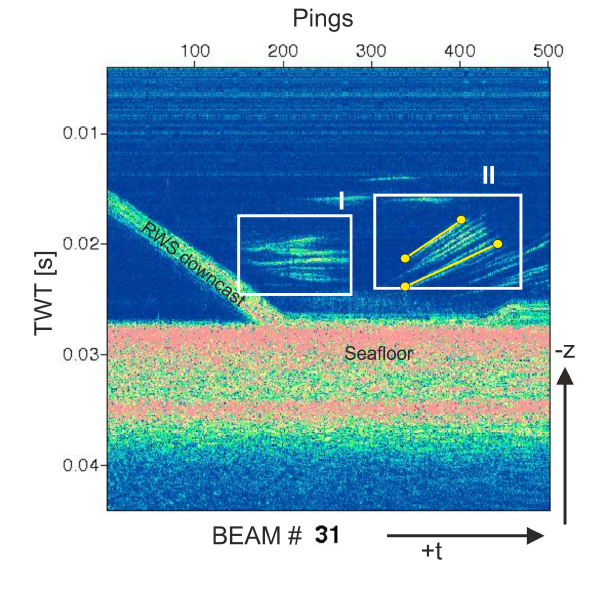
Fig. 3. “Beam slice” representation with the x axis corresponding to ping times (1 ping = 150ms) and the y-axis showing two-way- travel time for Beam 31. The downcast of the rosette-water-sampler (RWS) is seen in the left of the image. Horizontal straight lines are seen at p = 150 (I). Further to the right of the image (at p ∼ 320), a compound of rising gas bubbles occurs